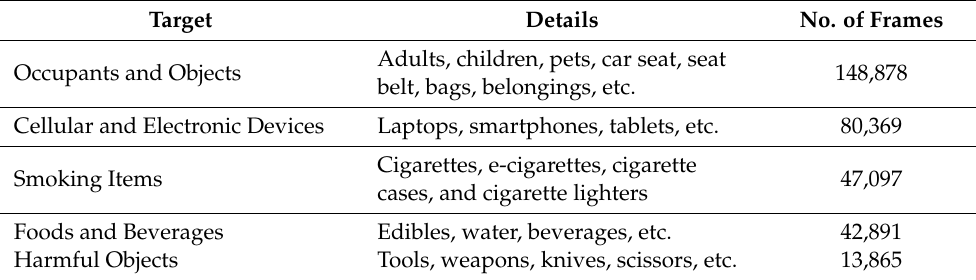
Table 3. Different targets with details and their number of images in our DB.